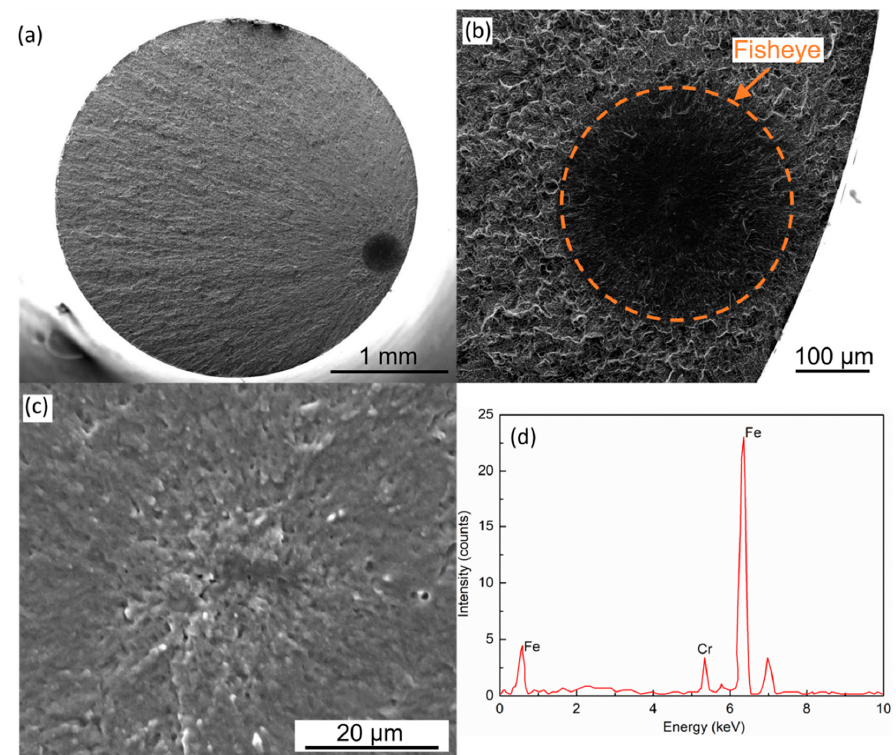
Figure 8. Typical morphologies of the fatigue crack initiated from the steel matrix: ( a ) Fracture surface; ( b ) fish eye structure; ( c ) inclusion in the crack initiation site; ( d ) EDS analysis of the inclusion.